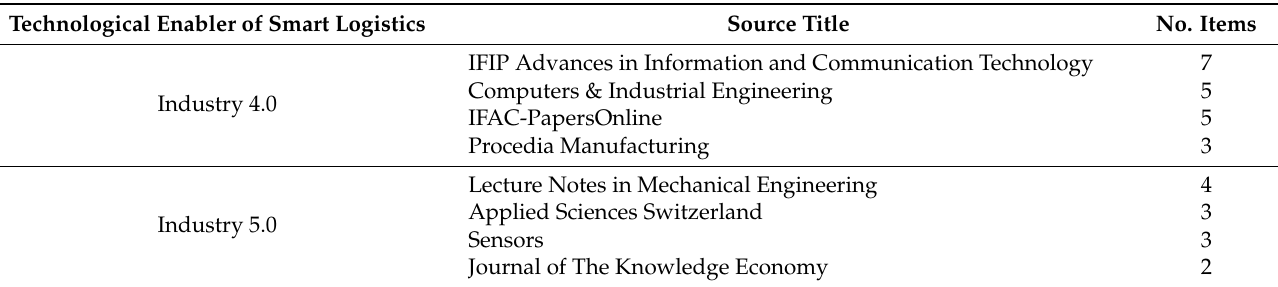
Table 2. Distribution of top contributing